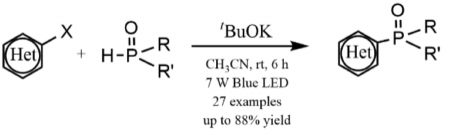
Figure 21. Visible light-promoted phosphinylation of heteroaryl halides in the presence of t -BuOK. Reprinted with permission from Ref. [71]. Copyright 2018, American Chemical Society.